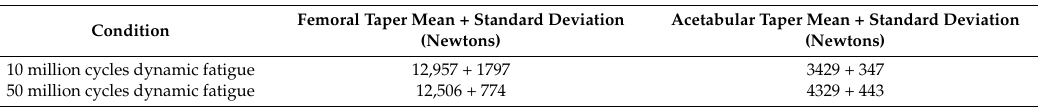
Table 1. Taper disassembly forces after dynamic fatigue testing where 16,000 N of force or greater is indicative of clinically relevant corrosion.